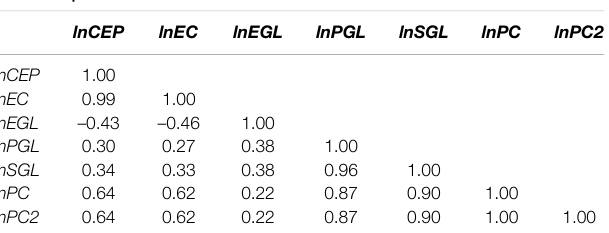
TABLE 3 | Correlation results.